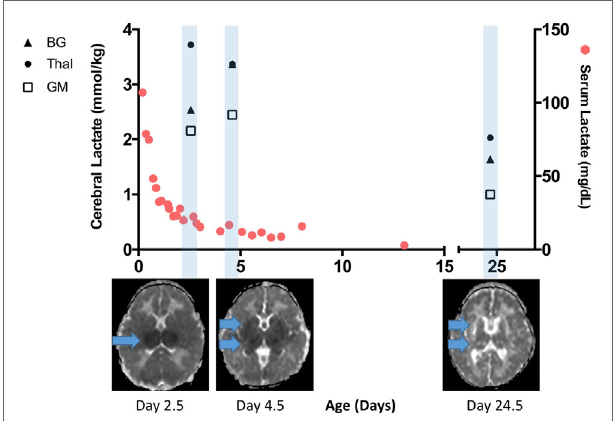
FigUre 5 | Time-resolution of serum and cerebral lactate in an infant with severe brain injury without any significant end organ injury. Serum lactate rapidly normalized and was < 20 mg/dL when the first cerebral lactate was markedly elevated. A repeat scan performed at more than 3 weeks of age reveals lower but still elevated cerebral lactate, especially in the basal ganglia (BG) and thalamus (Thal) regions. Apparent diffusion coefficient map below the x -axis reveals progression of injury from the early scan during therapeutic hypothermia (TH) to post-TH, and then chronic injury seen on day 24.5. Cerebral lactate concentration at the BG, Thal, and gray matter (GM) region are denoted here in closed triangle, closed circle, and open square,